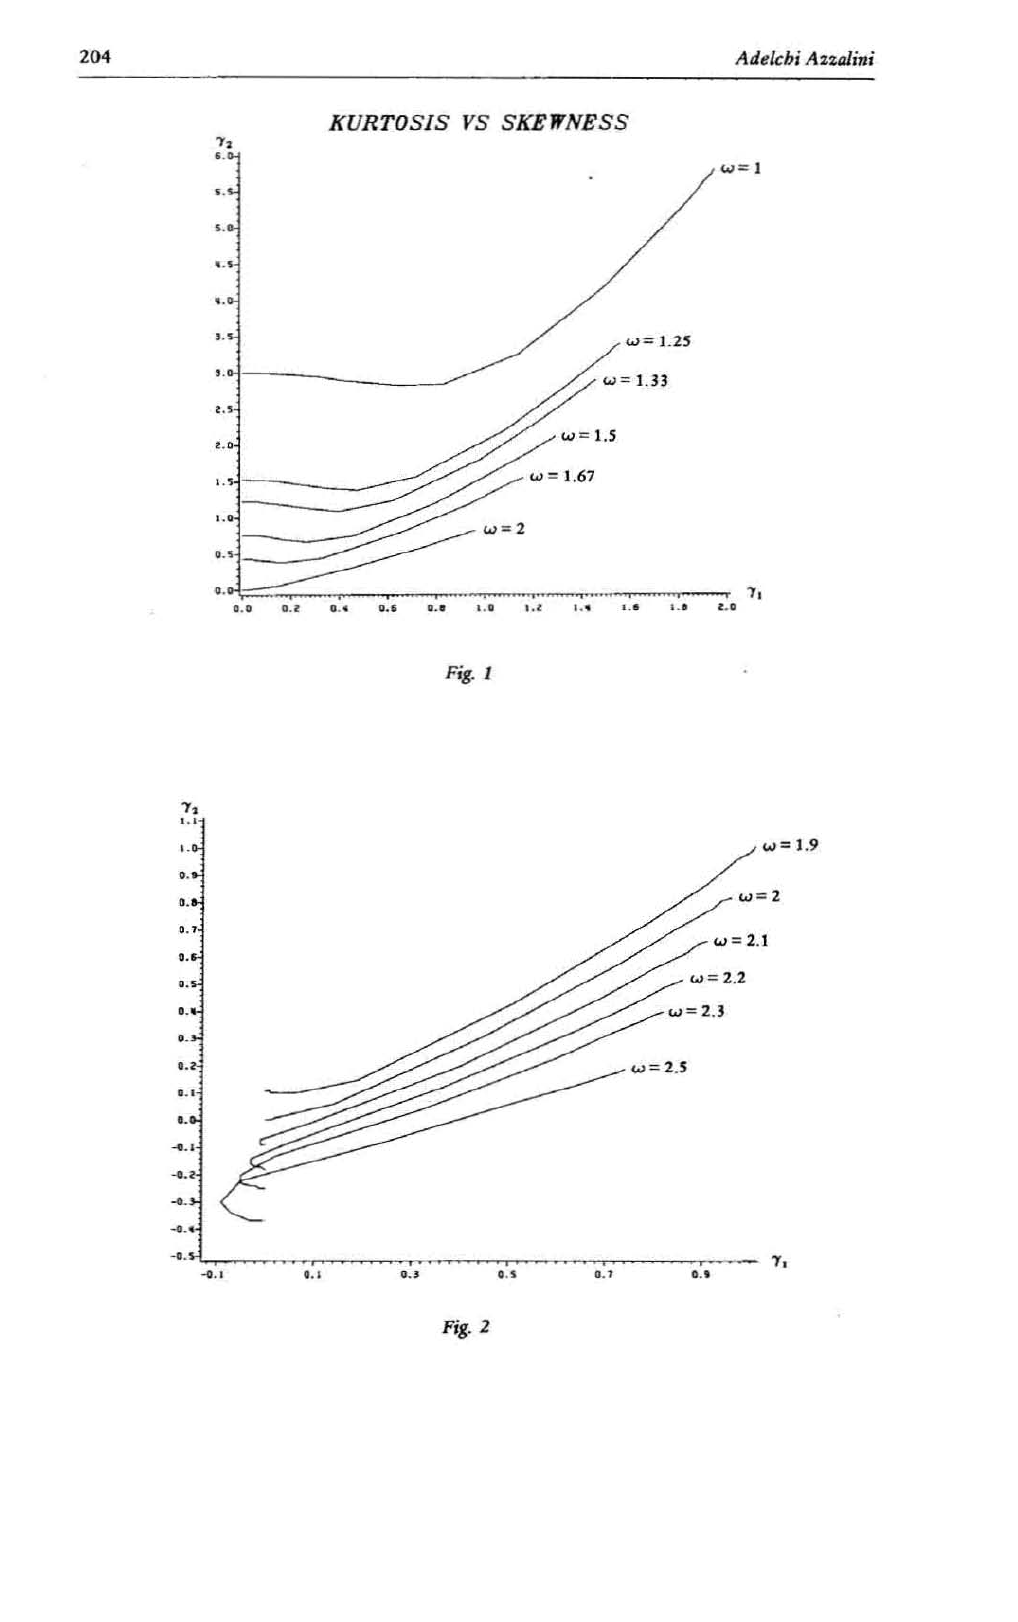
w= w=2 w=2.1 w=2.2 w=2.3